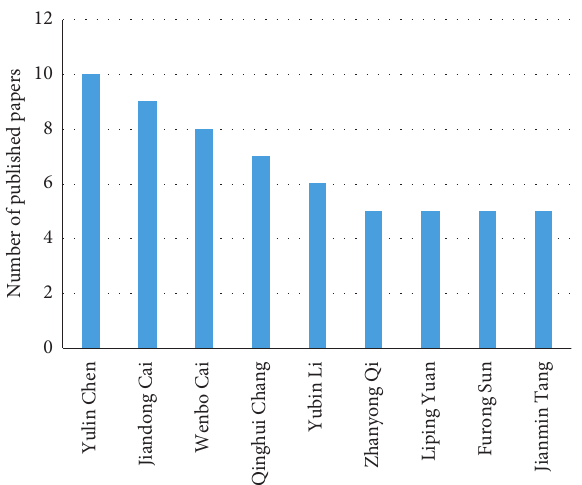
Figure 3: Papers published by prolific Table 1: High-frequency keywords.